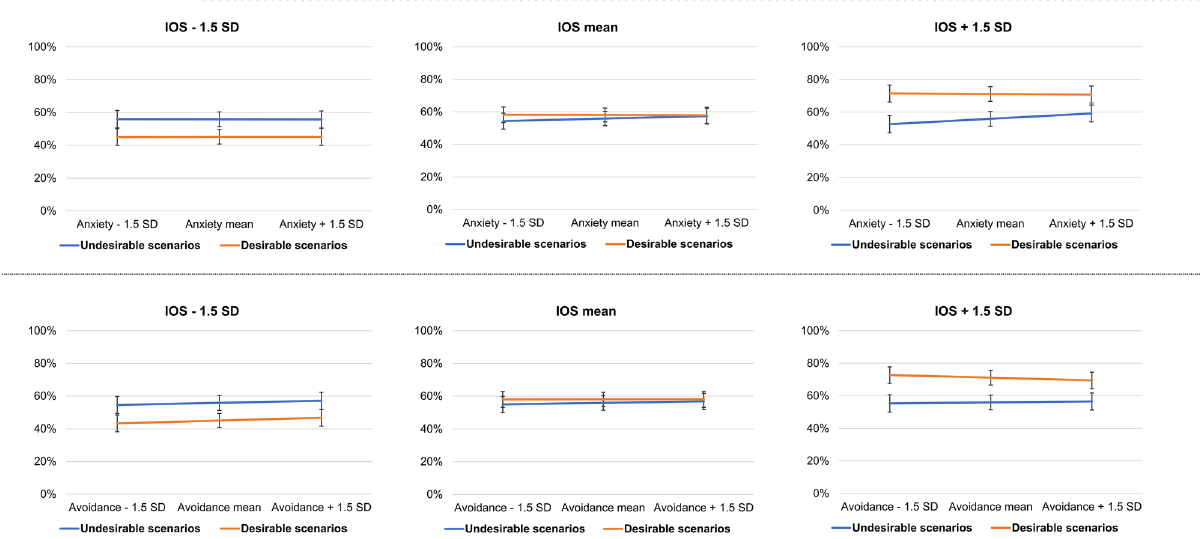
Figure 5. Interaction effect between IOS, valence and attachment dimensions. The bars represent 95% confidence